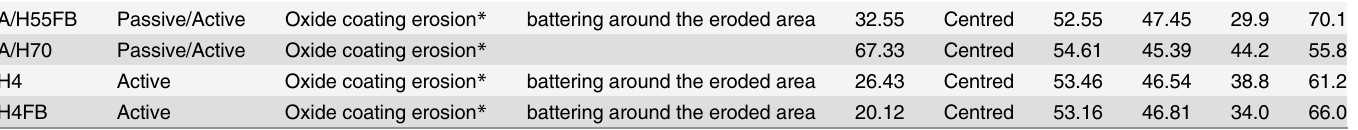
Table 5. Main characteristics of damage patterns, compared with the morphometric depressions, ridges and lowest roughness areas (polished